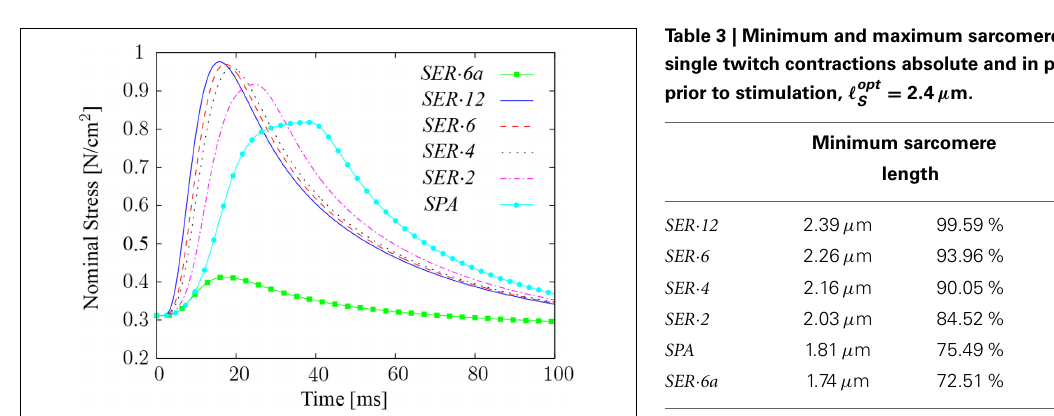
FIGURE 10 | Comparison of single twitch contractions in a spanning-fibered model and in series-fibered models with different fiber lengths and number of compartments. The reader is referred to the text for model definitions.